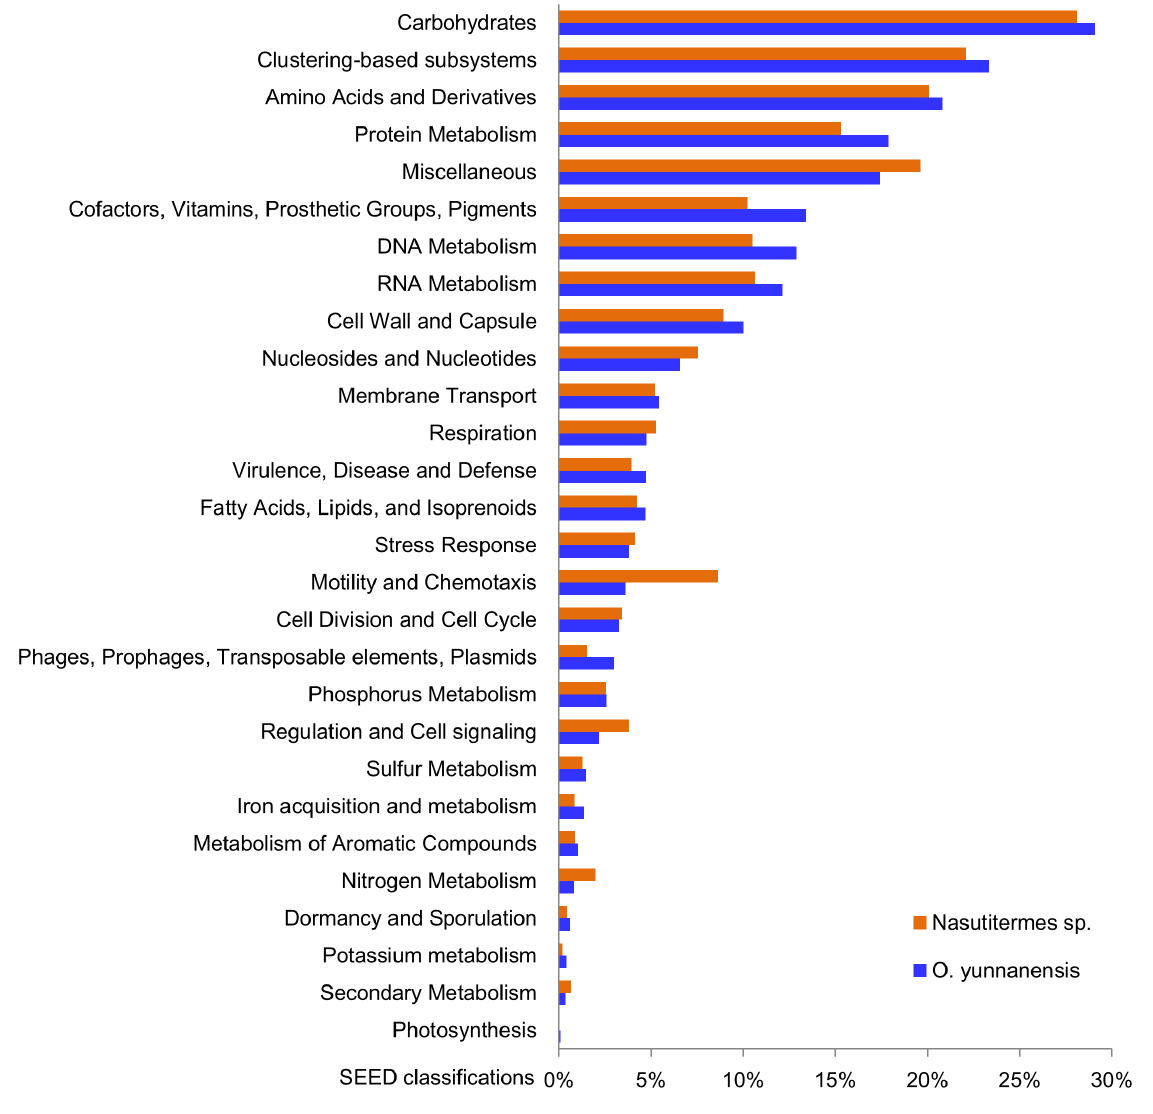
Figure 1. SEED profiles of gut microbiota of fungus-cultivating O. yunnanensis and wood-feeding Nasutitermes sp. [ 15 ] . The proportions of environmental gene tags (EGTs) in each classification with respect to the number of all annotated ones in individual metagenome were presented.